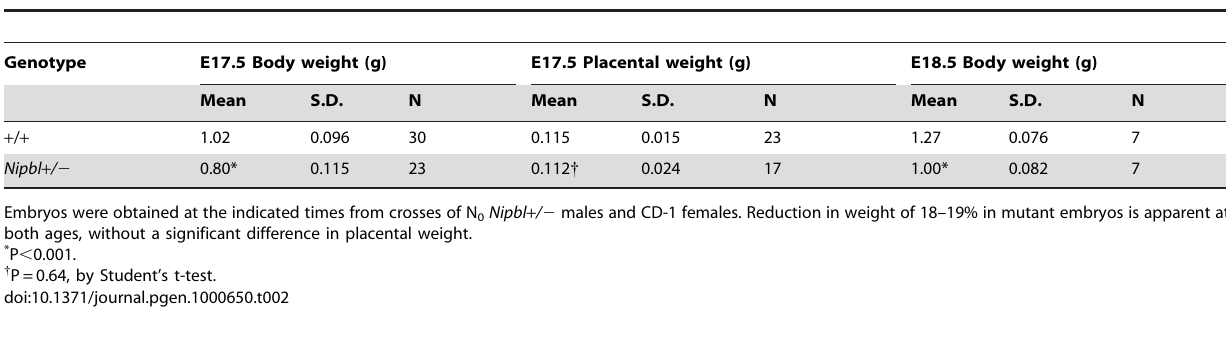
Paternal genotype Surviving $ 3 postnatal weeks Viable at